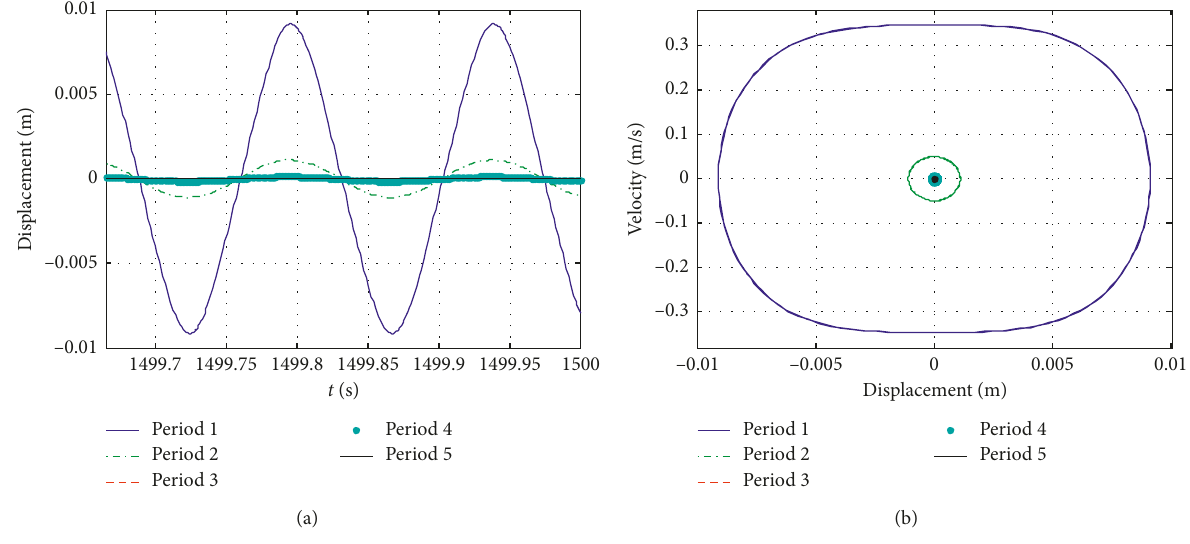
Figure 8: Five periodic shells’ (a) displacement time history curves and (b) phase diagrams.